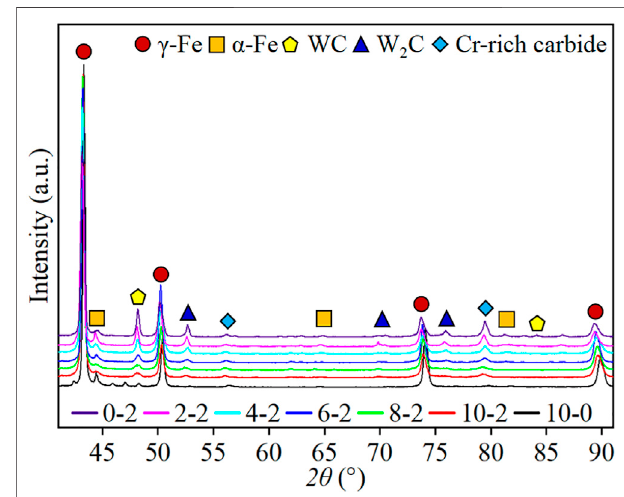
FIGURE 2 | XRD patterns of the samples with different Co